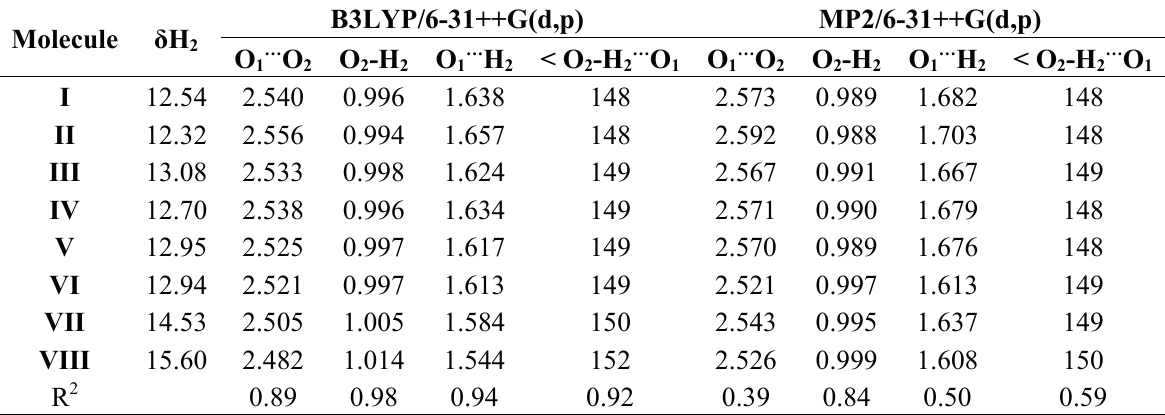
Table 1. 1 H-NMR chemical shifts for H and geometrical parameters for hydrogen bonds 2 calculated at B3LYP/6-31++G(d,p) and MP2/6-31++G(d,p) level of theory. The numbering of compounds is according to Figure